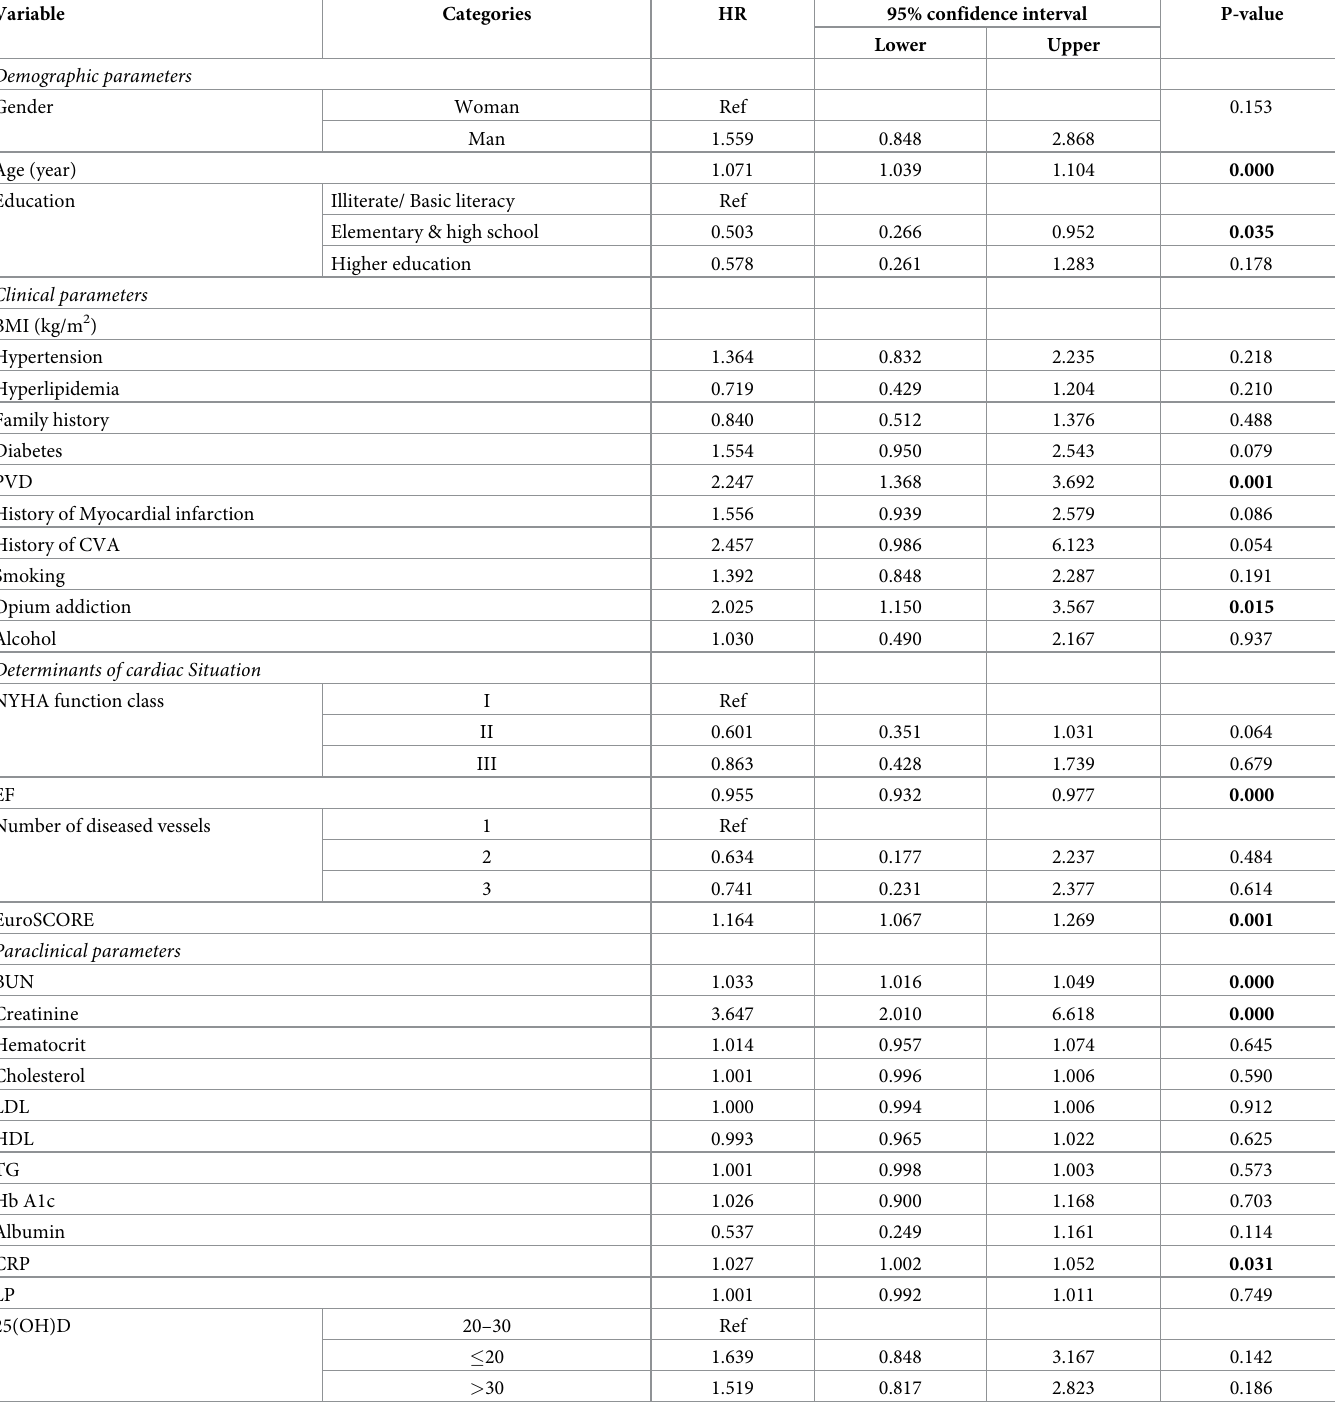
Table 2. Demographic, clinical and preclinical parameters at the beginning in patients undergoing coronary artery bypass grafting surgery and their relationship with 10-year